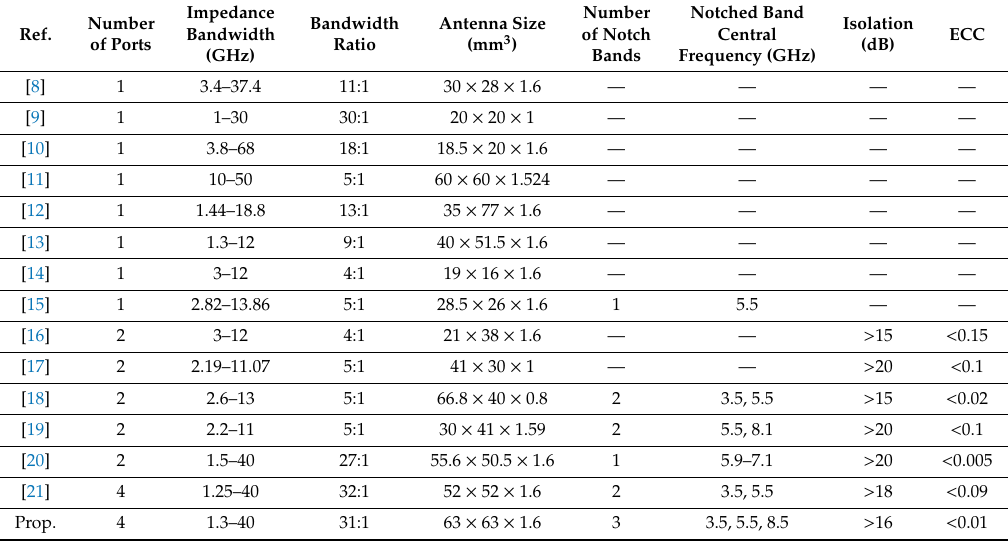
Table 2. Comparison of di ff erent parameters of the designed antenna with existing designs.